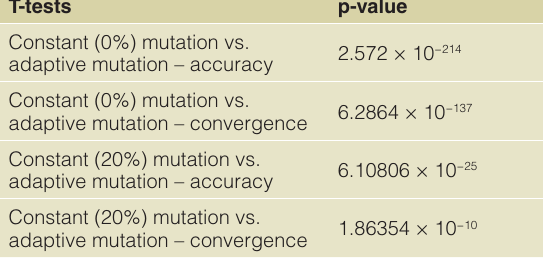
Table 4. Summary of statistical tests on 3-dimensional maximization results comparing the accuracies and convergence generations associated with adaptive and constant mutation